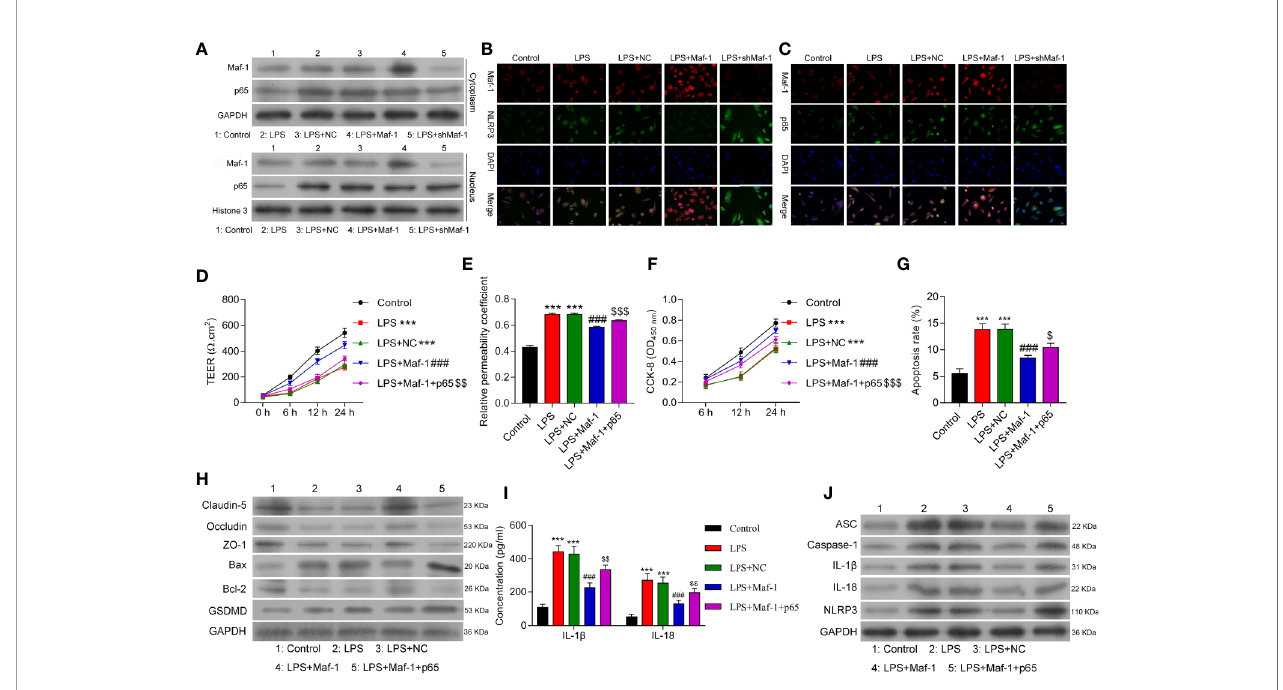
FIGURE 3 | Overexpression of p65 reversed the effects of Maf1 on in vitro BBB integrity, cell viability, and apoptosis in response to LPS. Cells were treated as shown in Figure 1 . (A) The cytoplasm and nucleus were separated. Western blot analyses of Maf1 and p65 expression in the cytoplasm and nucleus. (B) The co- location and expression levels of Maf1 and NLRP3 were determined by immuno fl uorescence assays. (C) Immuno fl uorescence staining of Maf1 and p65 is shown. BMECs were transfected with the control vector (NC), Maf1, or a combination of Maf1and p65, followed by LPS stimulation. The BMECs were then co-cultured with astrocytes to establish an in vitro BBB model. (D) The TEER of values of monolayer cells at 0, 6, 12, and 24 h were measured using a bioelectric impedance analyzer. (E) Trans-endothelial permeability assays were performed to assess in vitro BBB integrity by using the diffusion of 10 kDa FITC-dextran method. The relative permeability coef fi cient was determined after the Transwell experiment. (F) Cell viability was analyzed using the CCK-8 assay. (G) Quanti fi cation of cell apoptosis. (H) Western blot results for the levels of Claudin-5, Occludin, ZO-1, Bax, Bcl-2, and GSDMD. (I) The cell-free conditioned culture medium was collected and analyzed for IL-1 b and IL-18 levels via ELISA (J) Western blot analyses of pro-in fl ammatory cytokine (ASC, Caspase-1, IL-1 b andIL-18) and NLRP3 expression levels. Data are expressed as the mean value ± SD of data obtained from three separate experiments. *** p < 0.001, compared with Control; ### p < 0.001, compared with LPS + NC; $ p < 0.05, $$ p < 0.01 and $$$ p < 0.05 compared with